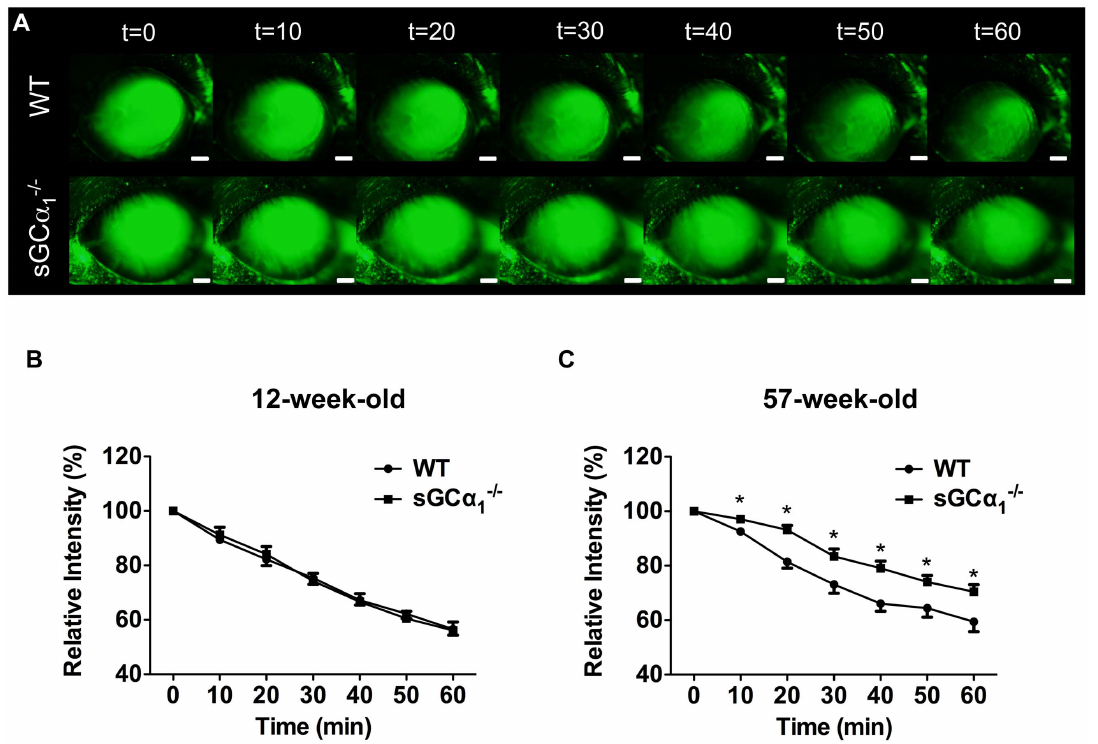
Figure 5. Decreased aqueous humor outflow rate in sGC a 1 2 / 2 mice. A : Shown is a representative series of images captured from 57-week- old wild-type (WT) and soluble guanylate cyclase a 1 -deficient (sGC a 1 2 / 2 ) mice at 10-minute intervals after application of fluorescein. Scale bars: 2 mm. B : In 12-week-old WT and sGC a 1 2 / 2 mice with similar IOPs (16 6 2 and 16 6 1 mmHg in n =9 and 8, respectively; P =0.91) the rate of AqH outflow did not differ, as shown by similar relative fluorescent intensities at all time points measured ( P =0.99) and similar exponential decay constants (0.0098 min 2 1 ( r 2 =0.997) and 0.0096 min 2 1 ( r 2 =0.998), respectively; P =0.12). C : IOP was greater in 57-week-old sGC a 1 2 / 2 mice than in age-matched WT mice (18 6 2 mmHg and 16 6 1, respectively; n =10 each; P =0.043), and AqH clearance was delayed in sGC a 1 2 / 2 mice, as shown by a lower exponential decay constant (0.0058 min 2 1 ( r 2 =0.972) versus 0.0092 min 2 1 ( r 2 =0.976), respectively; P =0.0056) and higher fluorescent intensities at all time points measured. * P =0.033, 0.0006, 0.024, 0.0029, 0.035, 0.025, between WT and sGC a 1 2 / 2 mice at 10, 20, 30, 40, 50, and 60 minutes, respectively.